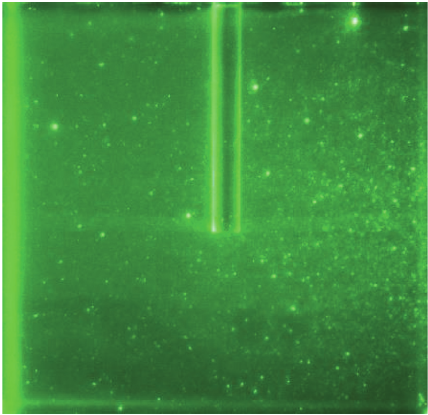
Figure 4: Speckle pattern of transparent